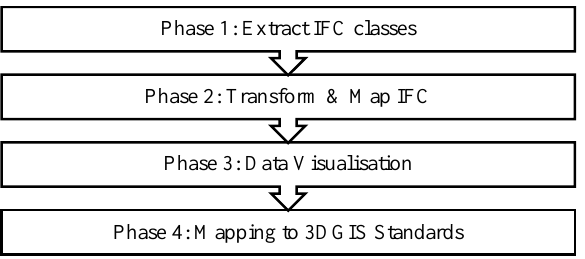
Figure 3: Overview of the proposed method